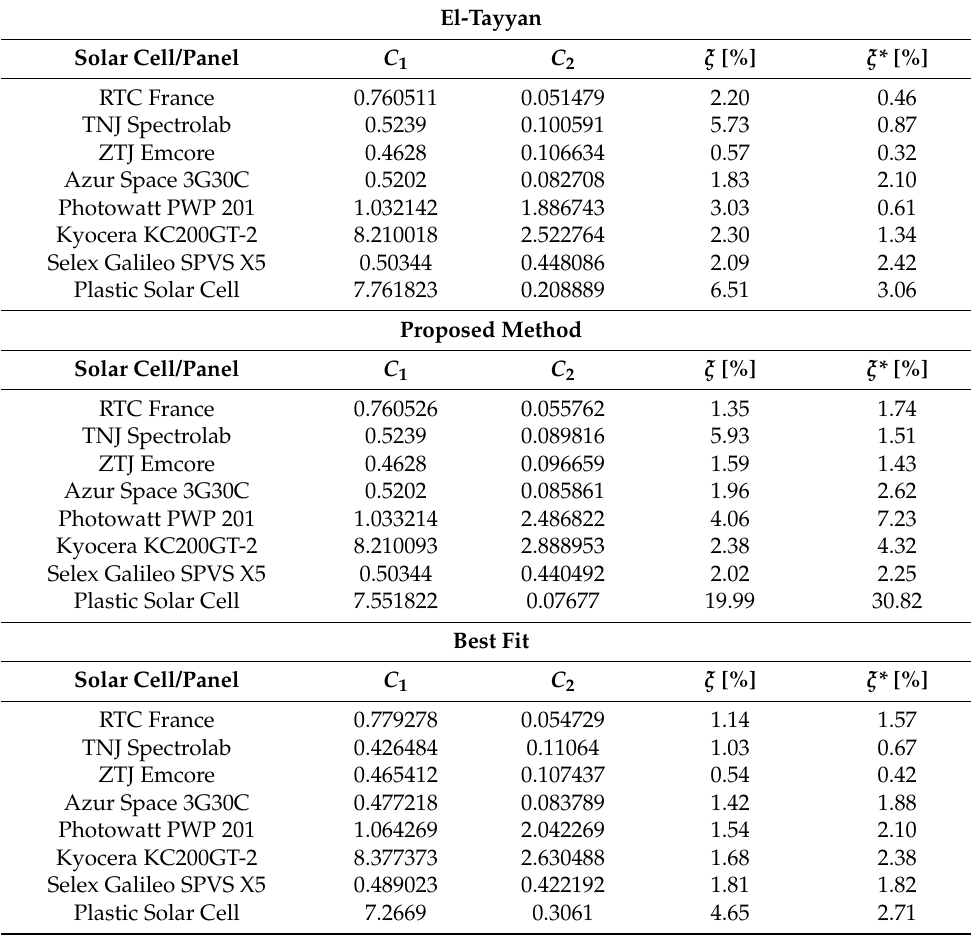
Table 4. Parameters from El-Tayyan’s explicit model Equation (12), fitted to the I – V curves for the photovoltaic devices studied (see Table 1). The fittings were performed numerically (best fit) with El-Tayyan’s formulae (Equation (13)), and using the proposed method (Equations (16) and (18)). The normalized RMSE values of the fittings, ξ , and ξ * , are included in the table.